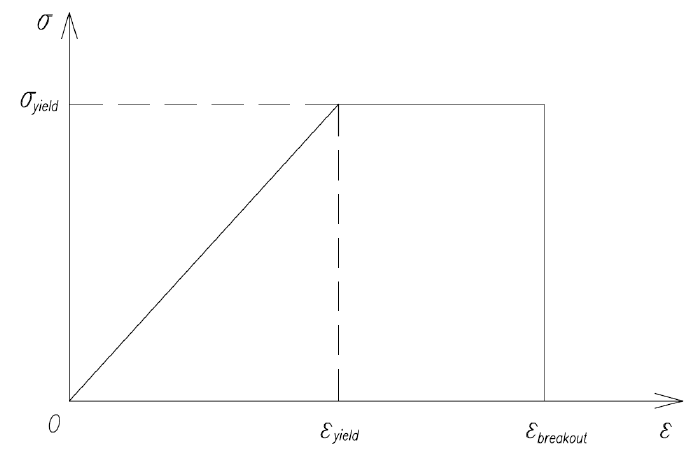
Figure 1. Sketch of the stress-strain relationship.